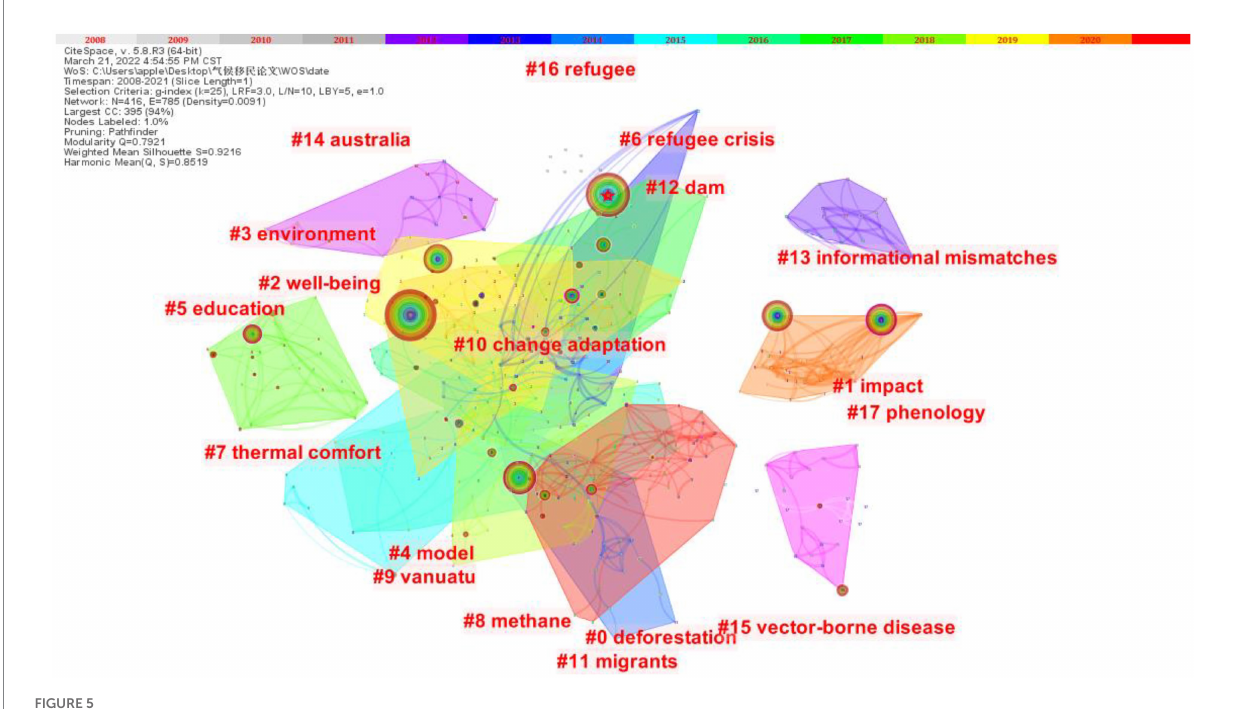
FIGURE 5 Keyword clustering map (WOS